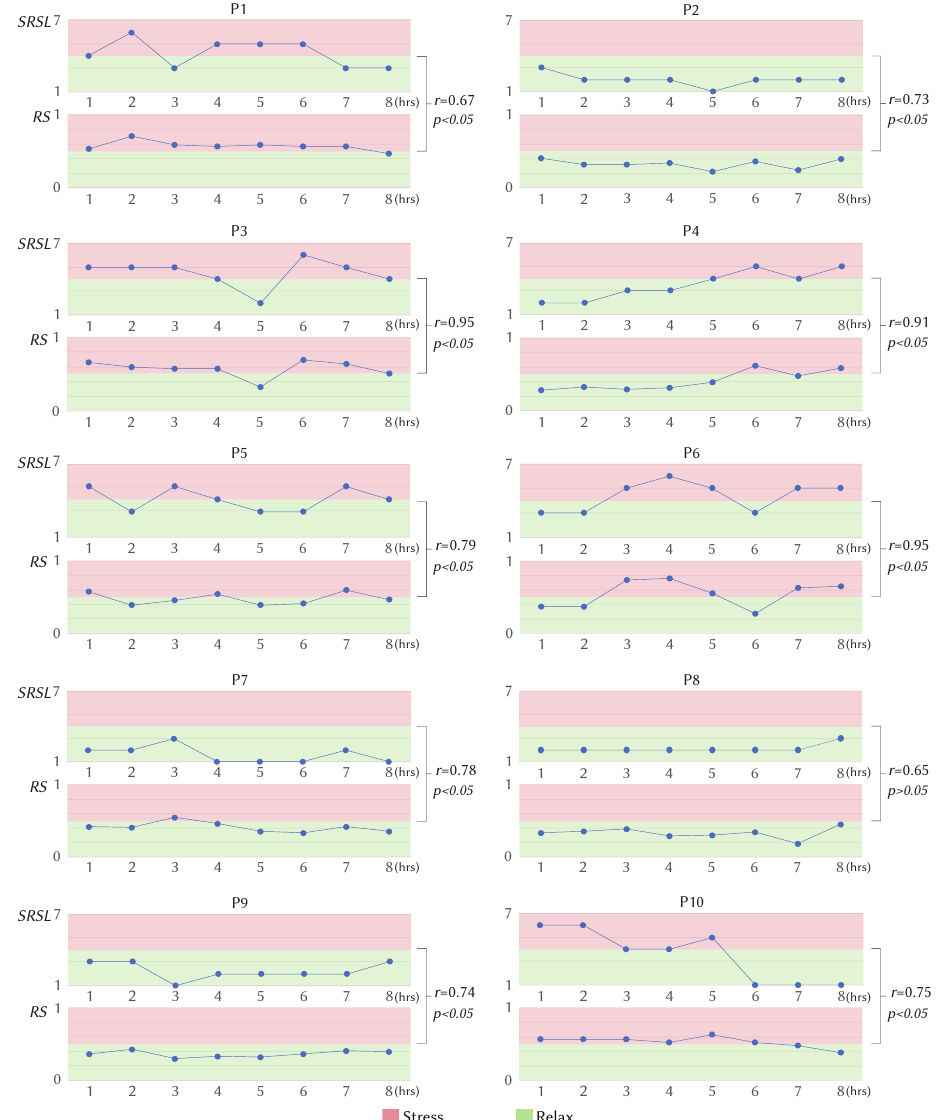
Figure 7. The figure shows the Self-Reported Stress Level ( SRSL ) and R S for each participant for each hour. Where R S = ( nWindows sitting ( Stressed ) / nWindows sitting ( Total )) . The Pearson’s Correlation Coefficient r and the level of significance p for each participant’s SRSL and R S is also